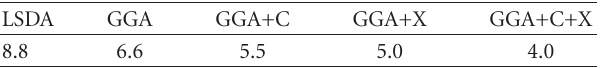
charge transfer is a result of an attractive potential. It turns out that positive and negative deviations from (1) exist in shells within all